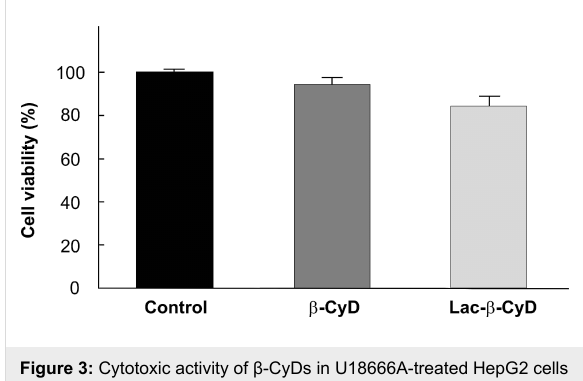
Figure 3: Cytotoxic activity of β -CyDs in U18666A-treated HepG2 cells after treatment for 24 h. U18666A-treated HepG2 cells were incubated with 100 μ L of medium containing 1 mM β -CyDs for 24 h at 37 °C. After washing once with PBS, 100 μ L of fresh HBSS and 10 μ L of WST-1 reagent were added to plates, and incubated for 30 min at 37 °C. Each value represents the mean ± S.E.M. of 6–8